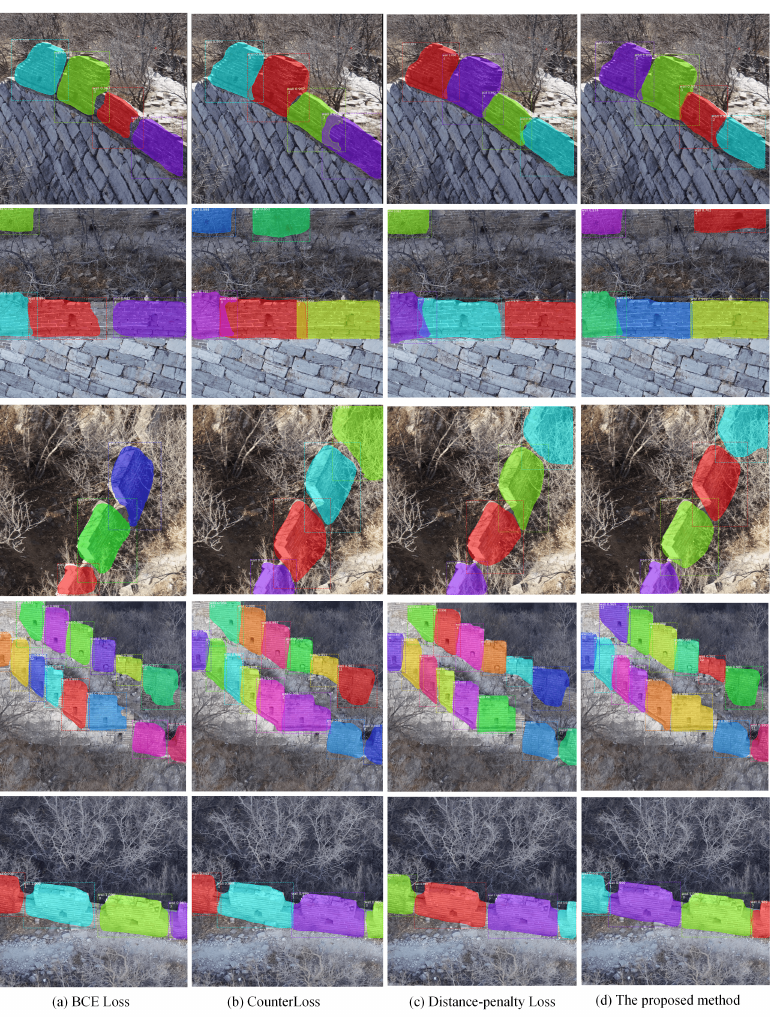
Figure 8. Instance segmentation results of Mask R-CNN trained with BCE Loss, ContourLoss, Distance-Penalty Loss and the proposed method. Table 2. Instance segmentation comparison of BCE Loss, Focal Loss, ContourLoss, Distance-Penalty Loss and the proposed method on the JKGW_WHU test